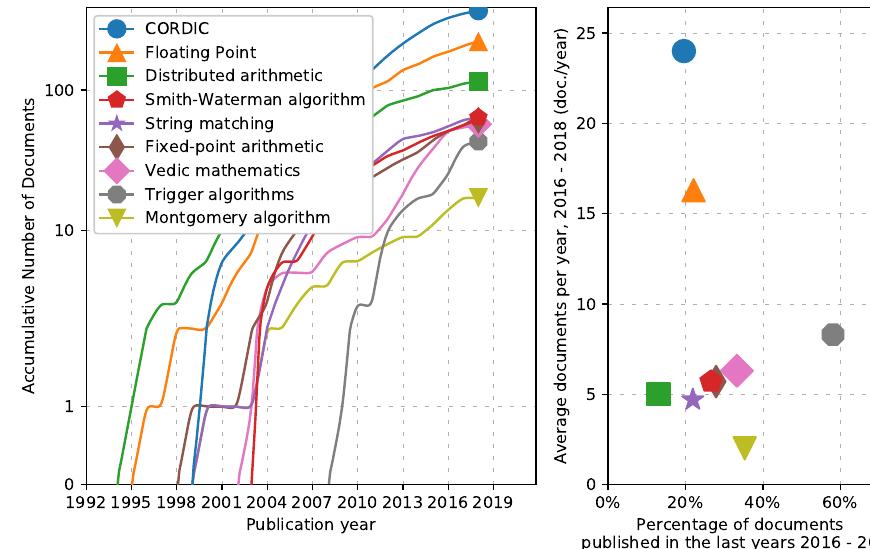
Figure 15. Top algorithms implementations in FPGA research.